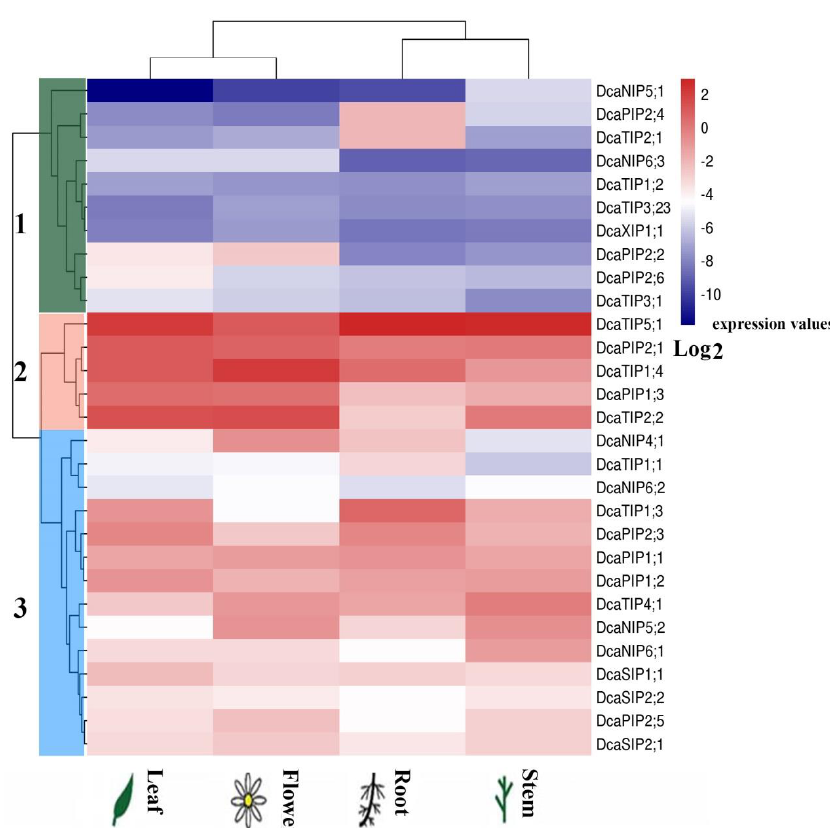
Figure 4. The qRT-PCR analysis of expression profiles in different tissues. Expression values of DcaAQP genes were calculated by comparative CT(2 −ΔΔCT ) method. A heat-map shows the hierarchical clustering of relative expression of all DcaAQP genes across in four different tissues analyzed. The vertical color scale at right of the image represents log 2expression values : red indicates a high level and blue represents a low of transcript abundance.